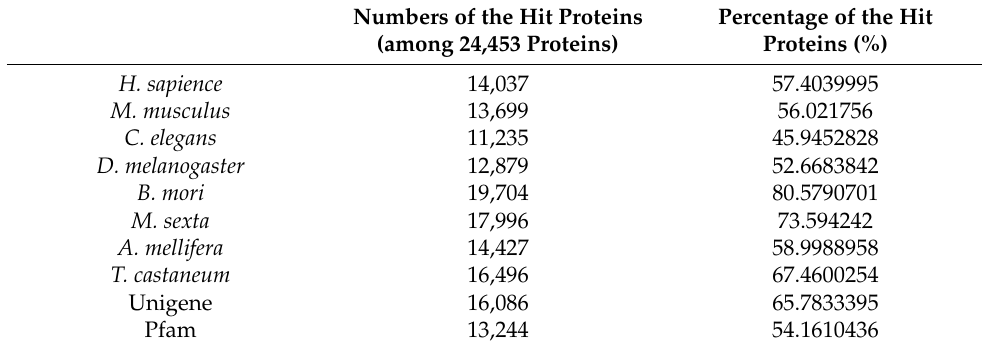
Table 4. Numbers of hit genes in each data set by